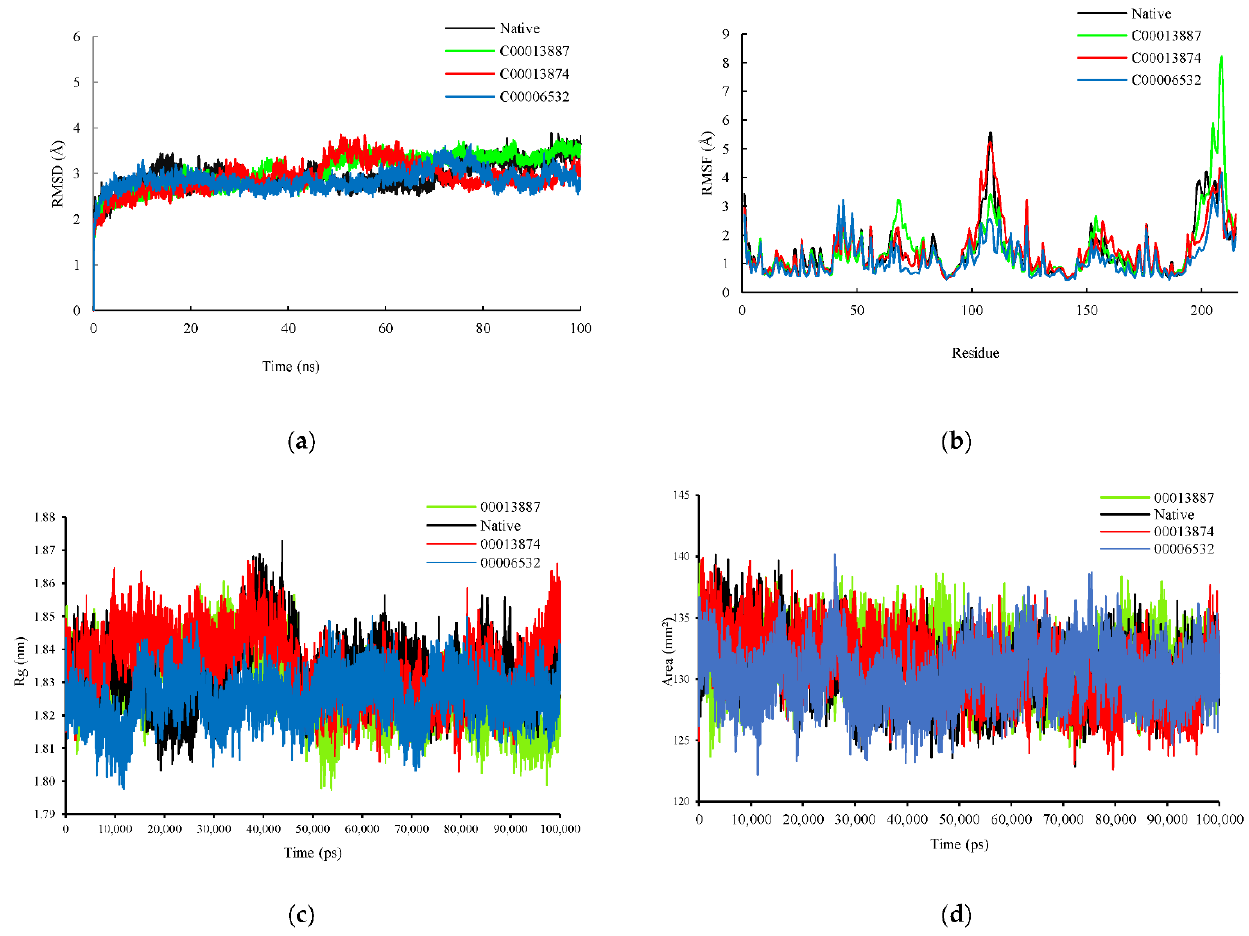
Figure 3. Evaluation of ( a ) RMSD, ( b ) RMSF, ( c ) radius gyration, and ( d ) SASA plot plots during MD simulations. The complex of protein-native ligand (NAD) and protein-hit ligands have been represented in different colors. NAD (black), C00013887 (green), C00013874 (red), C00006532 (blue).